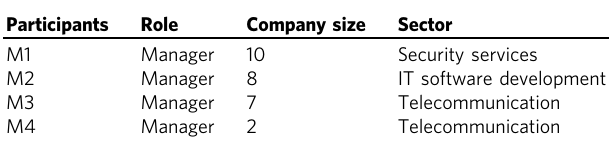
Table 1 Company pro fi le and participant pro fi le for the preliminary